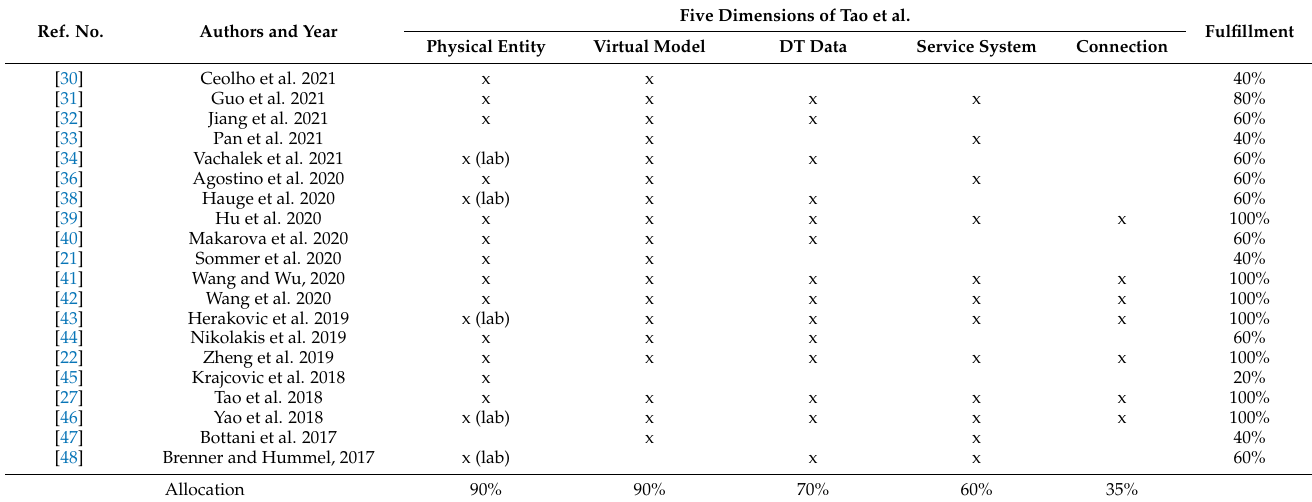
Table 9. Fulfillment of five dimensions of Digital Twins.